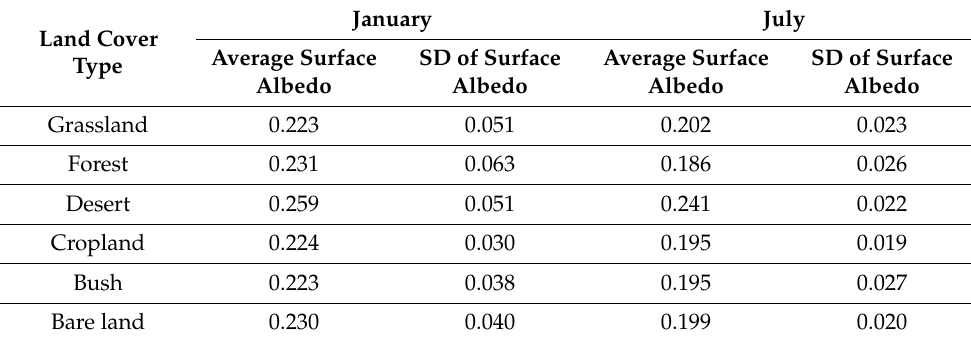
Table 5. Average and SD of surface albedo of different land cover types in January and July. Land Cover Type